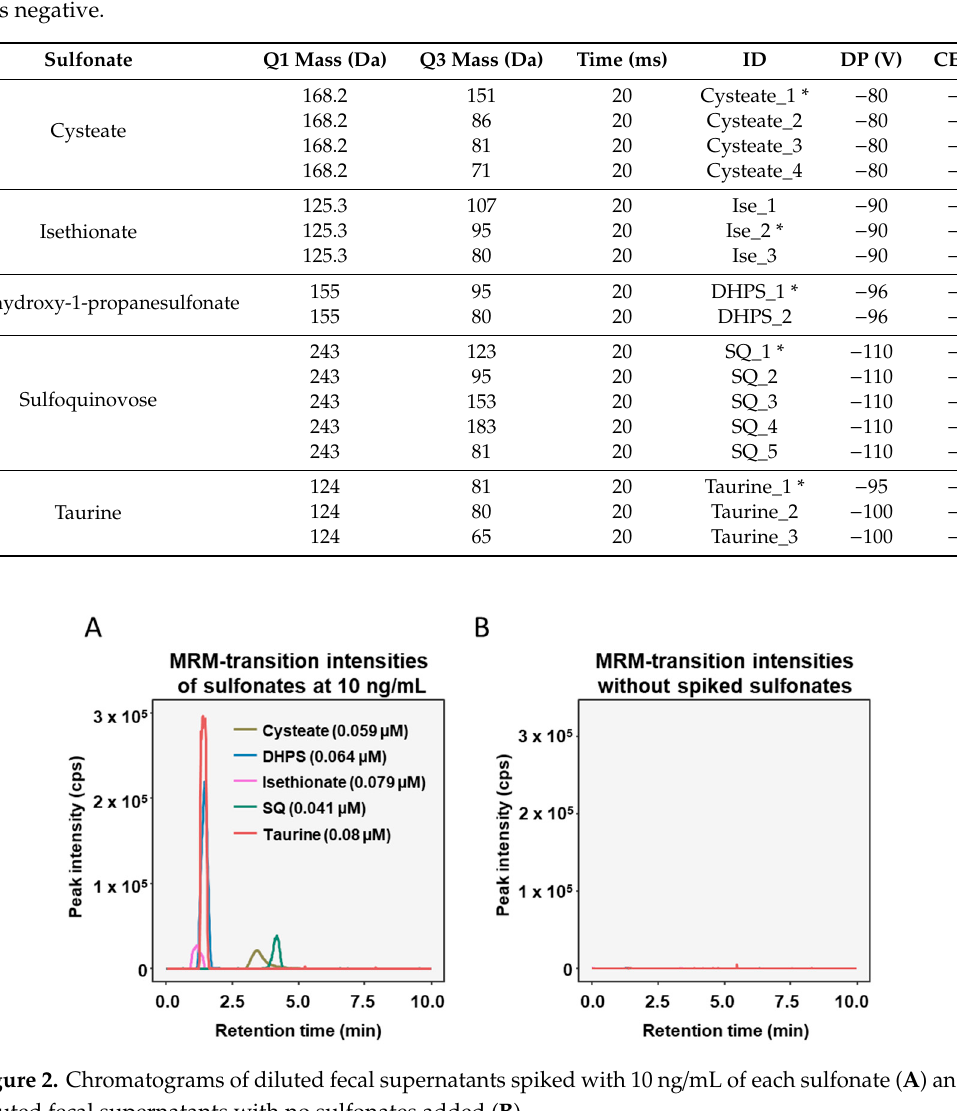
Figure 2. Chromatograms of diluted fecal supernatants spiked with 10 ng/mL of each sulfonate ( A ) and diluted fecal supernatants with no sulfonates added ( B ). Table 2. Level of detection (LOD), lower level of quantitation (LLOQ) and upper level of quantitation (ULOQ) of sulfonates in fecal supernatants analyzed at 1:10,000 dilution (1st, 2nd and 3rd columns); molar mass of sulfonates; and LLOQ and ULOQ of sulfonates in fecal supernatants before extraction and dilution.